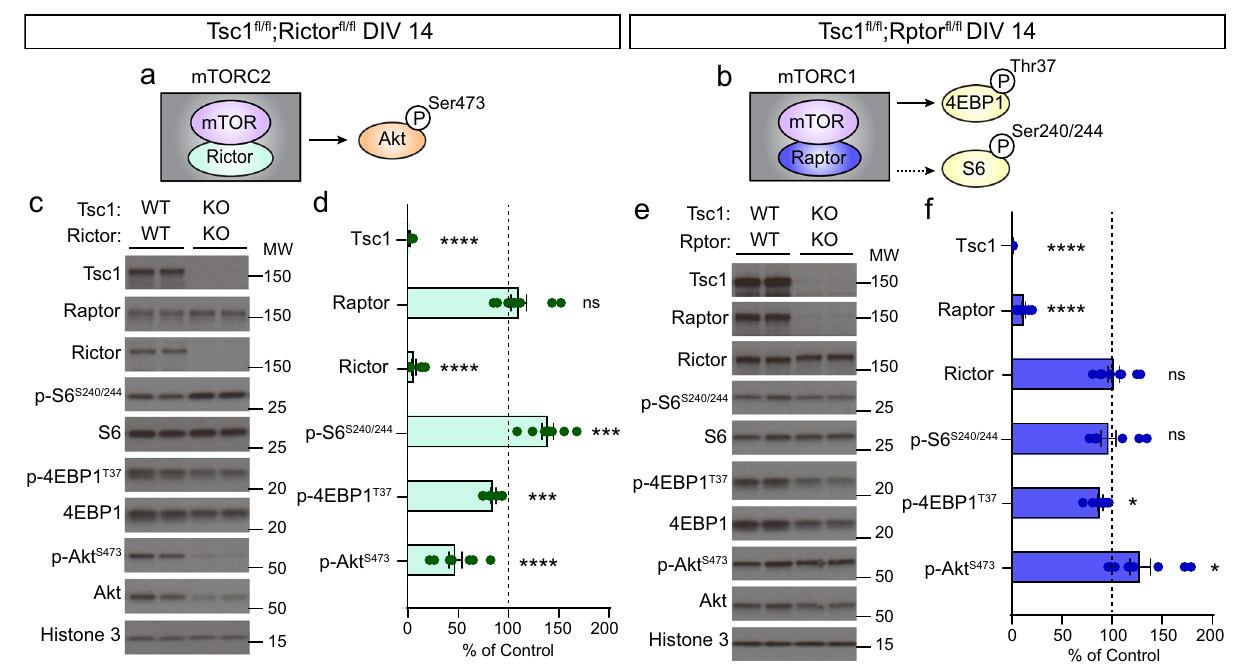
Fig.2|GeneticreductionofRaptoramelioratesmTORsignalingabnormalities in Tsc1-cKO neurons. a Simpli fi ed schematic of mTORC2 showing mTOR and its obligatory binding partner Rictor. mTORC2 phosphorylates Ser473 on Akt. b Simpli fi ed schematic of mTORC1 showing mTOR and its obligatory binding partnerRaptor.mTORC1 phosphorylates 4EBP1 (Thr37)and P70S6K,which inturn phosphorylates S6 at Ser240/244 (represented by the dashed line). c Representative western blots (WB) from Tsc1 fl / fl ; Rictor fl / fl hippocampal cultures treated with AAV-GFP (WT;WT) or AAV-Cre-GFP (KO;KO) and harvested on DIV 14. MW indicates molecular weight. Two independent samples per genotype are shown. This experiment was replicated three times. d Bar graphs display WB quanti fi cation (mean ± SEM) for the indicated proteins, expressed as a